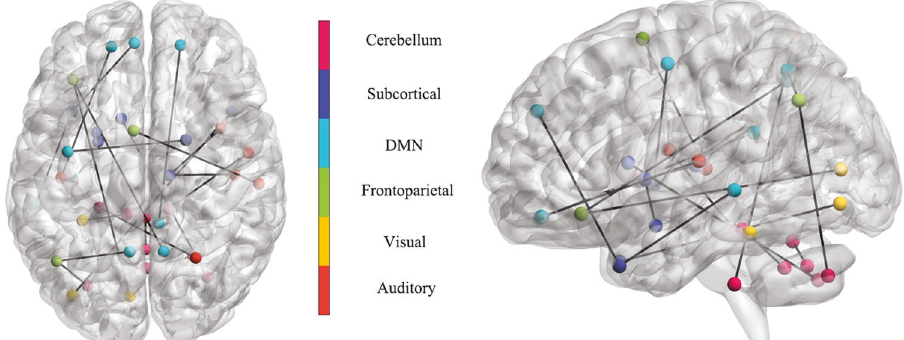
Fig. 3 The top 20 most important functional connectivity features obtained from the bayesian ridge model. These features consist of functional connectivity between the cerebellum superior and vermis8, medial superior frontal gyrus and middle temporal gyrus, amygdala and lenticular nucleus putamen, orbital inferior frontal gyrus and precuneus, angular gyrus and precuneus. Statistical values are obtained from Pearson correlations two-sided